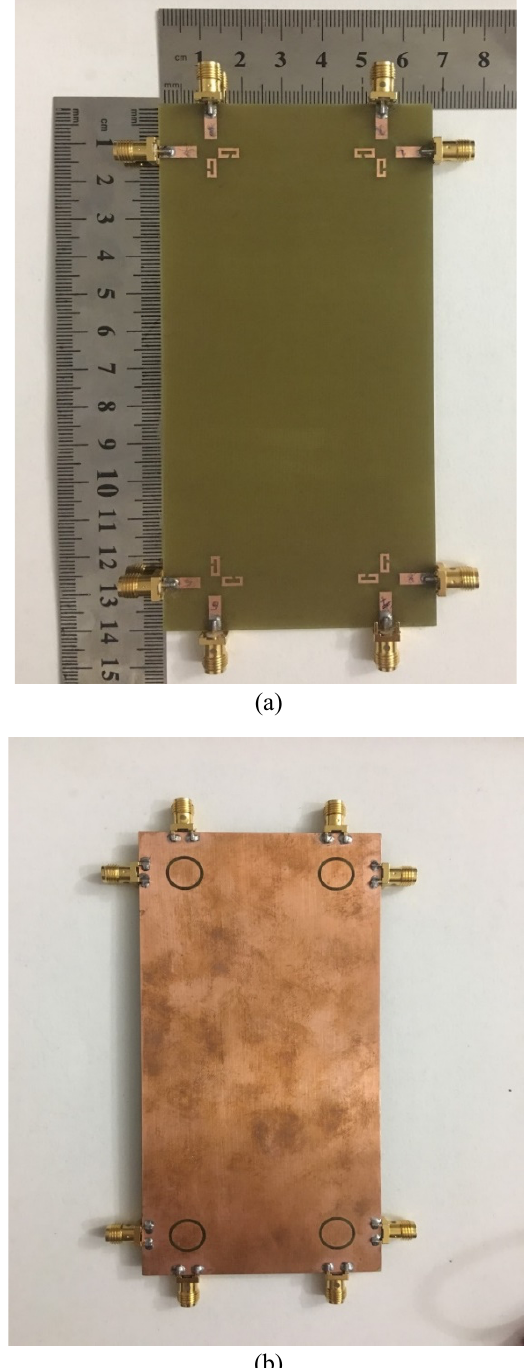
FIGURE 3: The fabrication of MIMO antenna system (a) top view and (b) bottom view